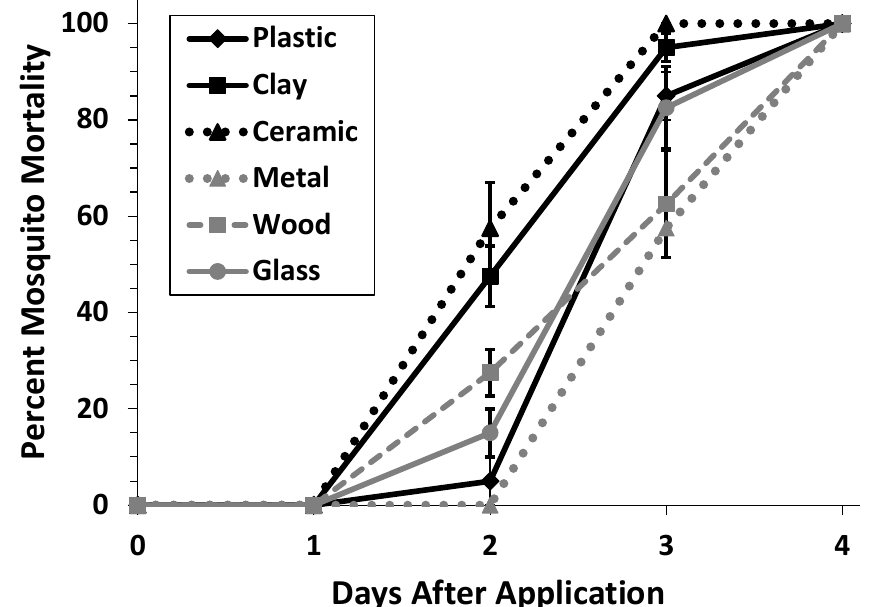
Figure 2. Percent mortality of Ae. aegypti when exposed to mosquitocidal chips containing 0.01% Pyriproxyfen in containers of di ff erent materials. No mortality was observed in untreated controls (not shown). Error bars represent ± SEM.